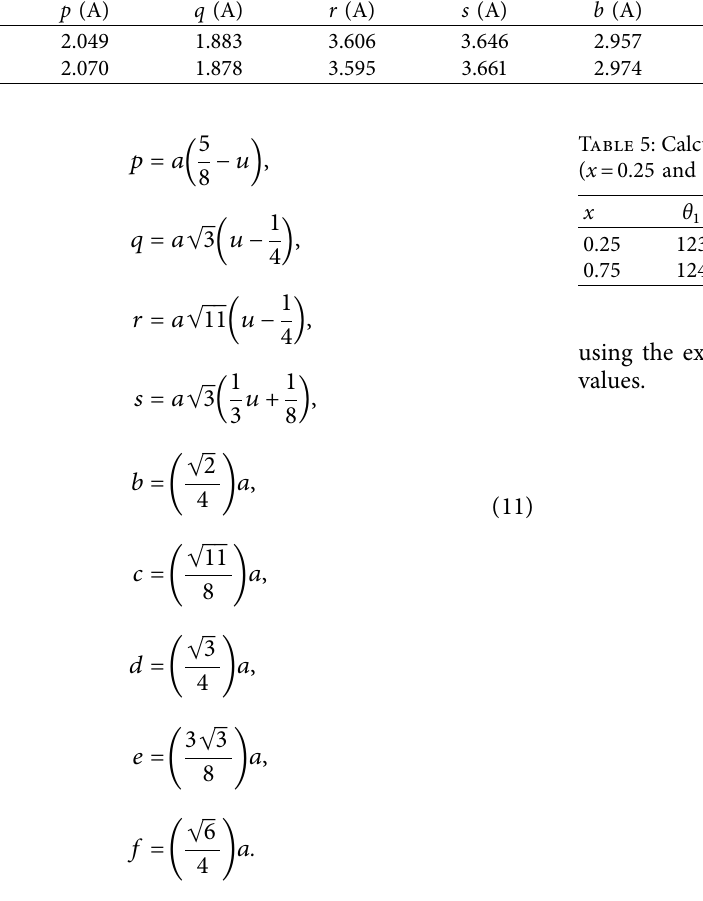
Figure 8: The interionic distances and interaction angles. Table 4: Calculated values of interionic distances of Ni � 0.25 and x � 0.75) annealed at 750 ° C. 1-x Zn x Fe 2 O 4 ferrite ( x x